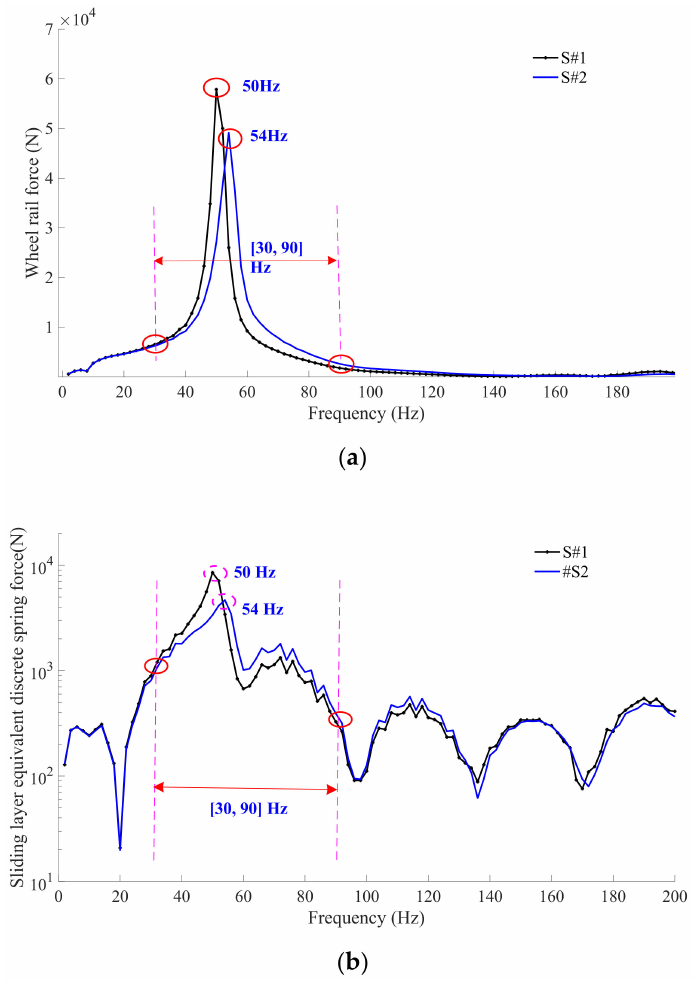
Figure 5. Vertical excitation of track–bridge system; ( a ) the wheel–rail force; ( b ) the equivalent discrete spring force of the sliding